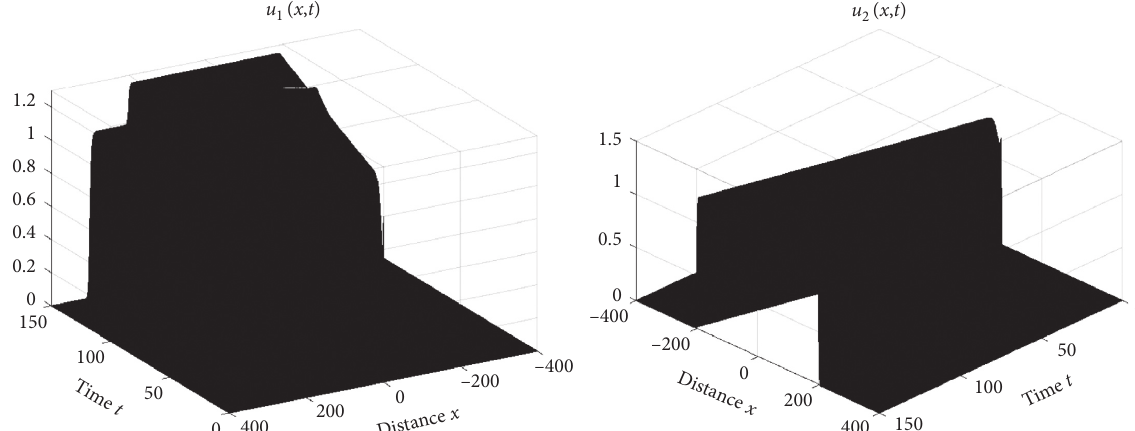
Figure 5: Simulation of ( u